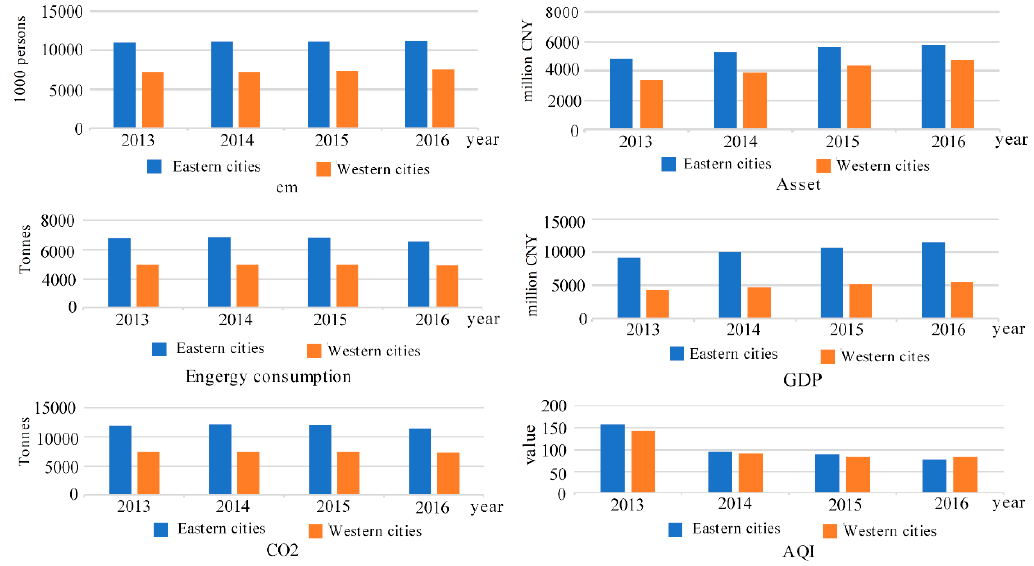
Figure 2. Input-output index statistical analysis.